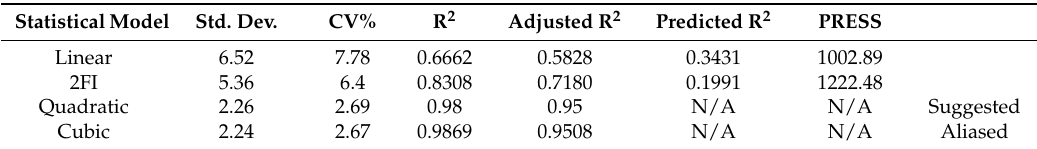
Table 6. Quadratic model statistics.